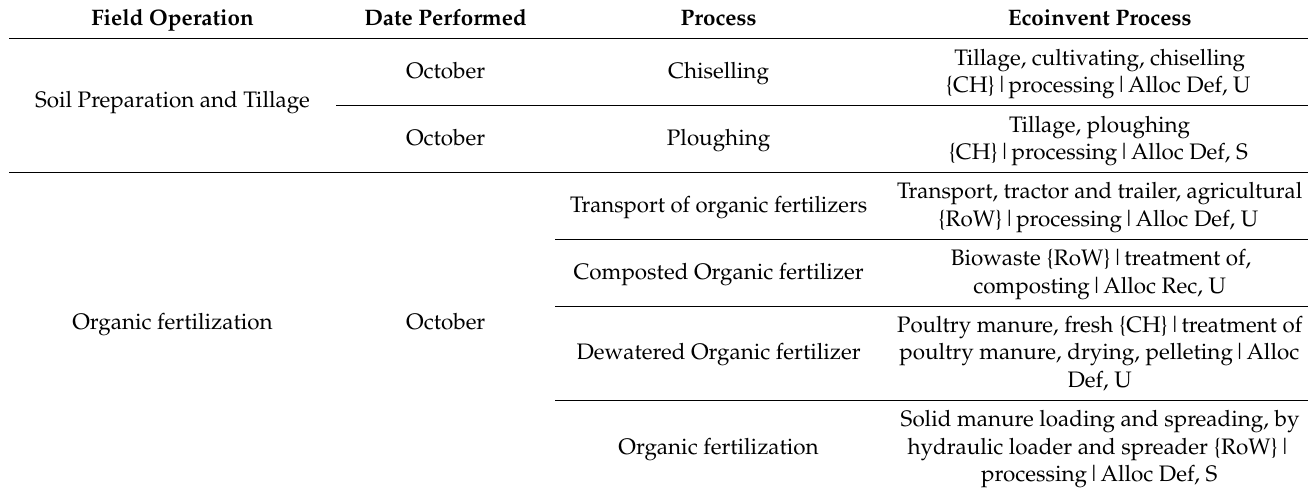
Table A2. Ecoinvent inventory of adapted processes for each season and organic fertilization with composted sludge and dewatered